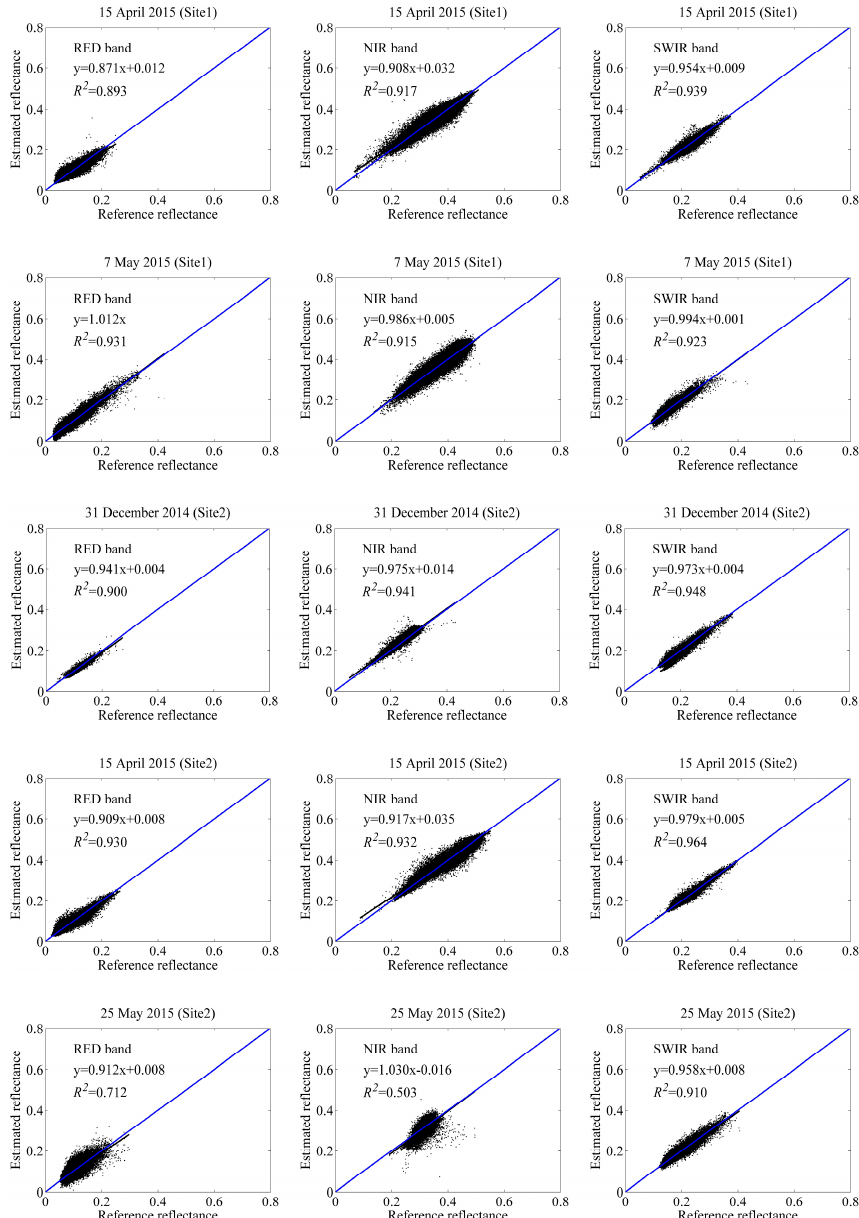
Figure 4. Per-pixel comparisons between the observed and predicted PROBA-V 100-m reflectance. The 1:1 line is blue, and the regression line is black.